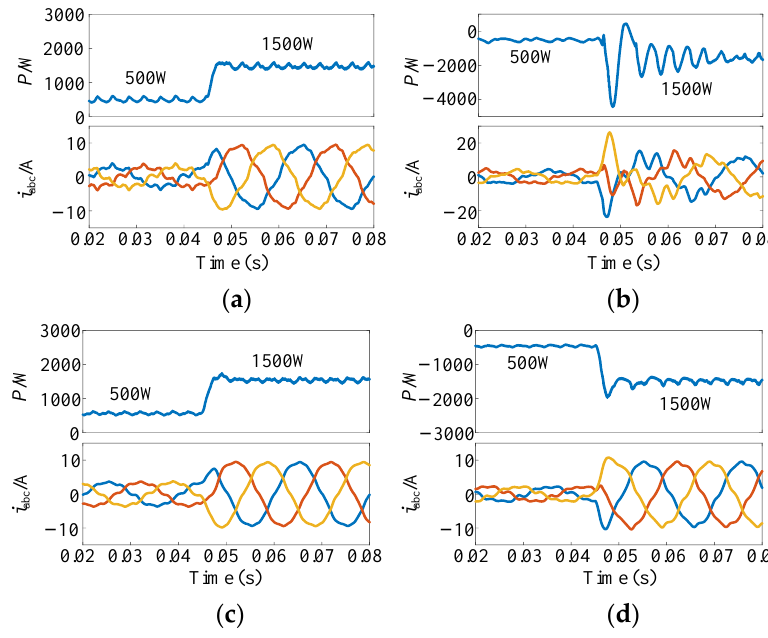
Figure 15. Simulation results at low-power level as P changes, with U d = 100 V. ( a ) Conventional control under forward power flow. ( b ) Conventional control under reverse power flow. ( c ) IRSE control under forward power flow. ( d ) IRSE control under reverse power flow.